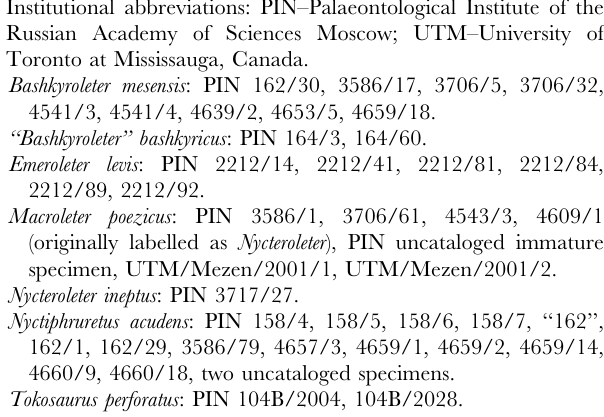
Table S1 Data matrix used for the phylogenetic analysis of Parareptilia.